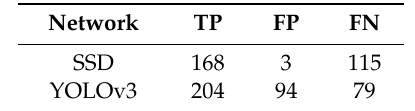
Table 3. Respective numbers of TP, FP and FN for SSD and YOLOv3 networks.